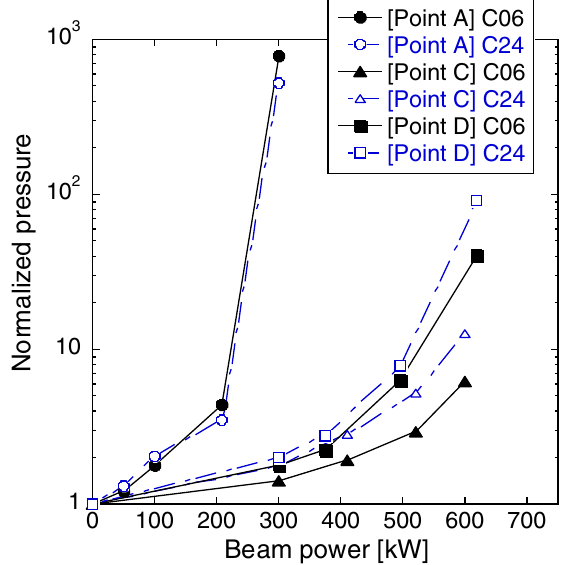
FIG. 16. Relation of the maximum pressure to each beam power in points A, C, and D of Fig. 14 [Figs. 15(a), 15(c), and 15(d)]. The CCG values in C06 and C24 are plotted as representatives. Each pressure value is normalized by the pressure without